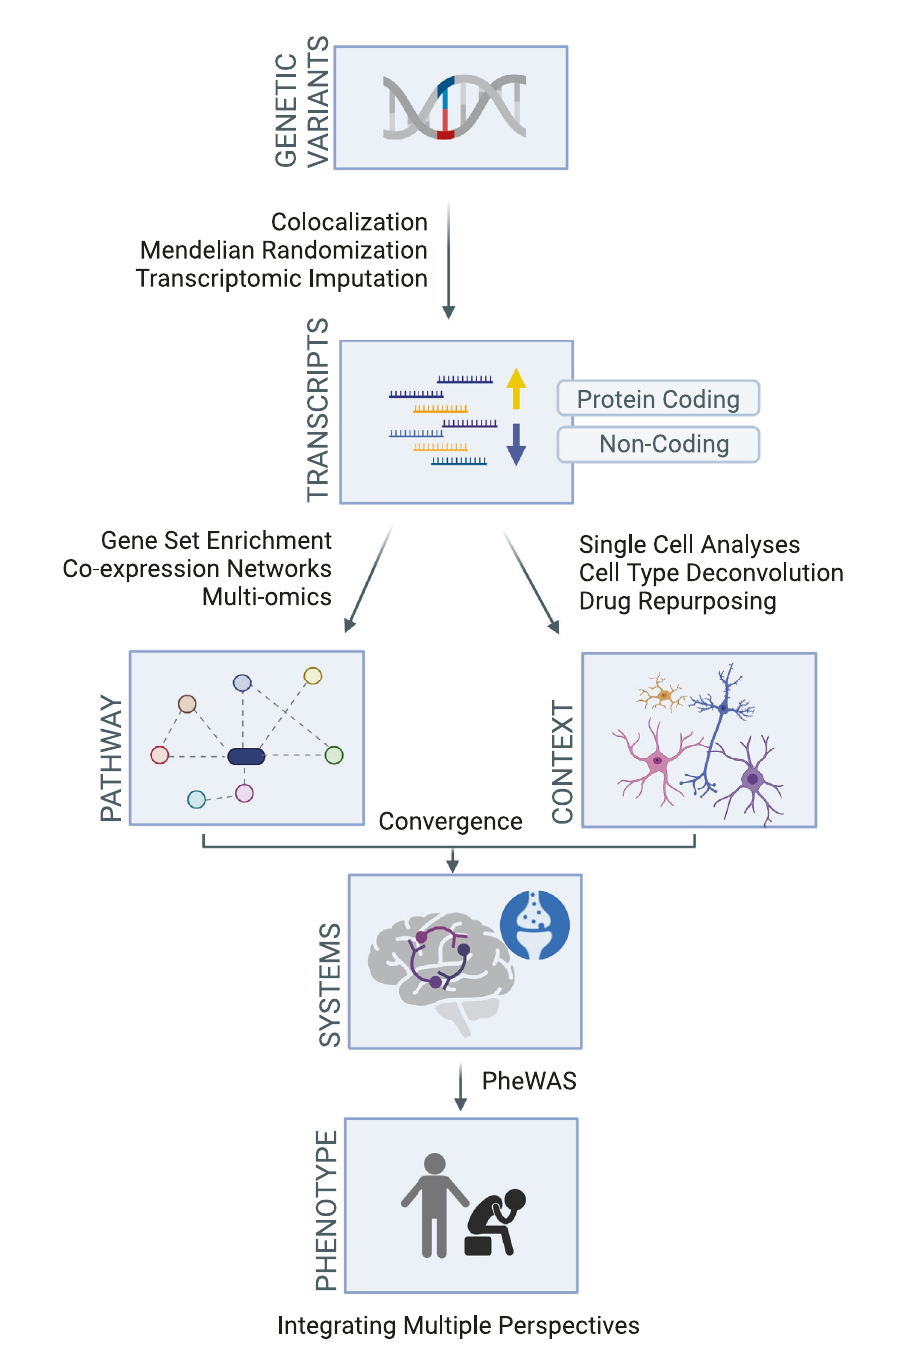
Fig. 2 Multiscale bioinformatic approaches to study depression genomics and transcriptomics. Created with to a gene body. QTL-based mapping approaches are a more dependable tool for mapping because they use existing associa- tions between genotype and gene expression from a reference dataset (e.g., GTEx [65] or psychENCODE [93]). Colocalization analysis asks whether a phenotype-associated risk SNP and an eQTL for a gene originate from the same genomic locus. As a complementary approach, Mendelian randomization (MR) uses the SNP associations as instrumental variables in a mock randomized control trial to infer causal directionality between gene expression and a trait. While neither of these methods can